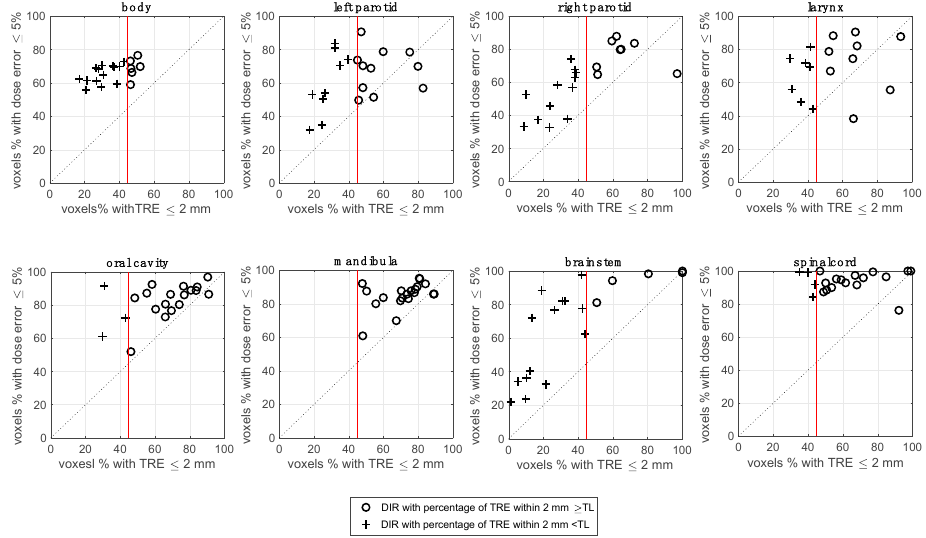
Figure 4. Correlation graph of the percentage of the TRE within 2 mm and percentage of voxels within 5% of dose error (3.5 Gy), across the 20 registrations and for each OAR. The ‘+’ markers indicate the cases for which the percentage of voxels was less than the 45% OTL, indicated as vertical red line. The OTL value was derived using TG132 datasets, as described in Section 3.4.